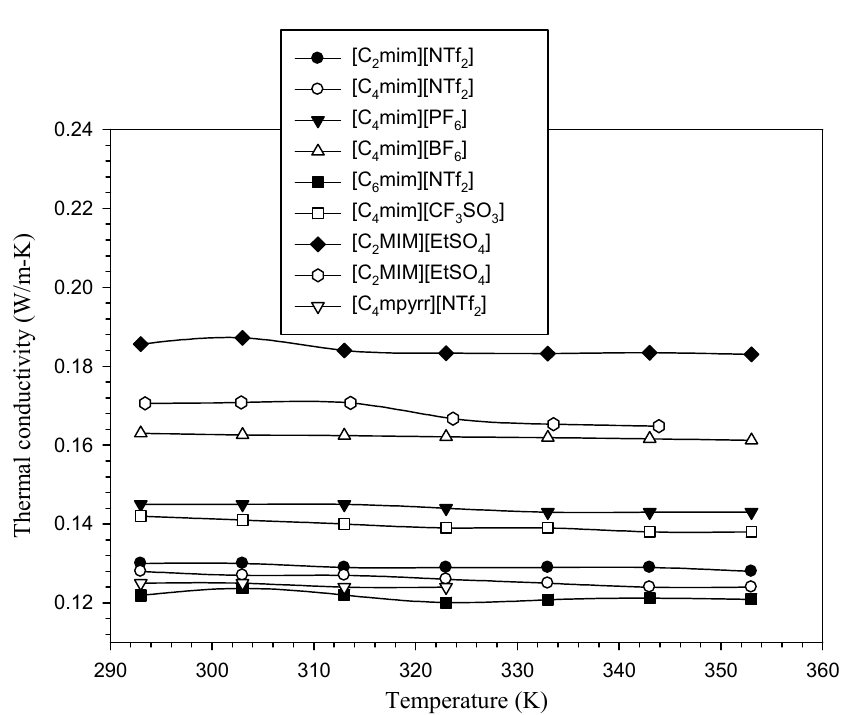
Figure 2. Effect of temperature on the thermal conductivity of ILs [4,48,53,54].